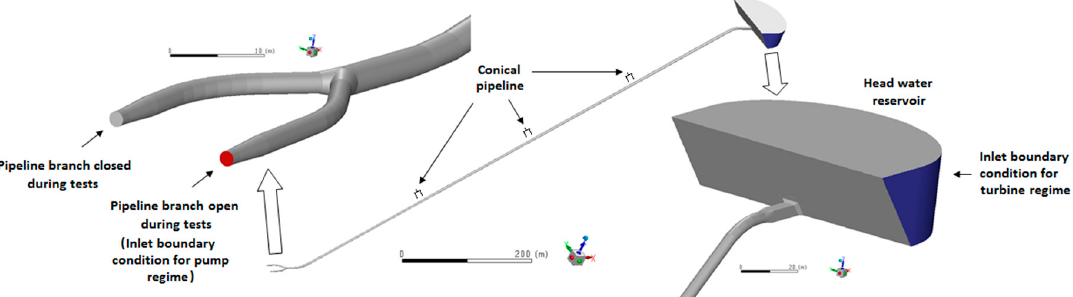
Figure 5. Geometry of hydraulic system (calculation domain): head water reservoir (hydraulic diameter of virtual half-cylindrical inlet 30 m) → square pipeline (4.3 × 4.3 m) → cylindrical pipe (4.3 m) → conical pipe (4.3 / 3.9 m) → cylindrical pipe (3.9 m) → conical pipe (3.9 / 3.6 m) → cylindrical pipe (3.6